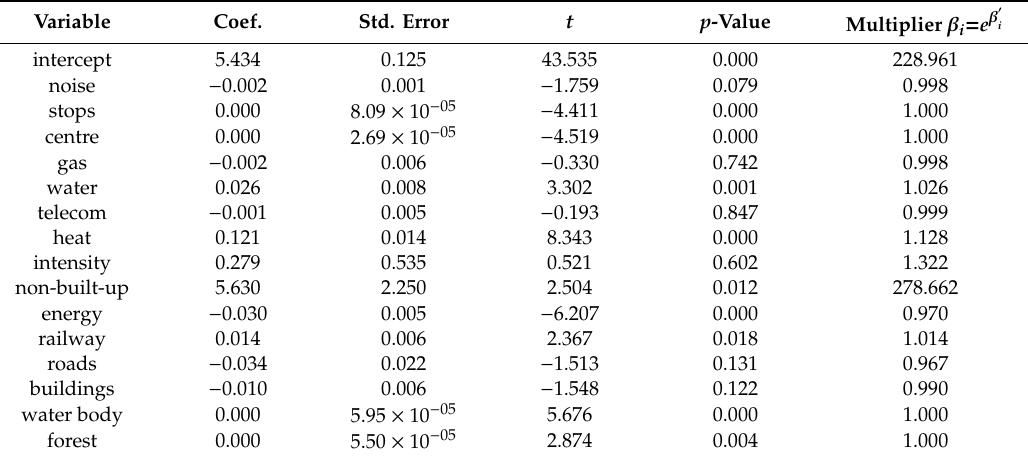
Table 4. Results of the multiple regression linear model estimation.